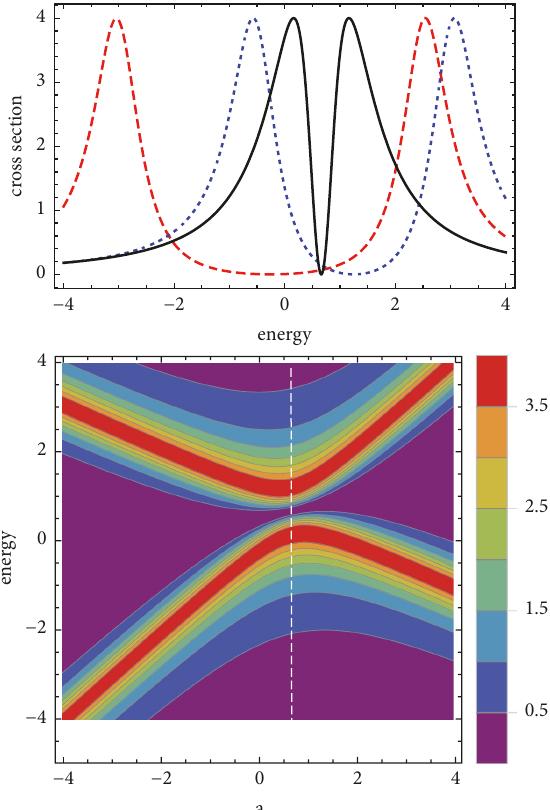
Figure 4: The same as Figure 2 but with vanishing external mixing, 𝜔 (1) = 𝜔 (2) = 0